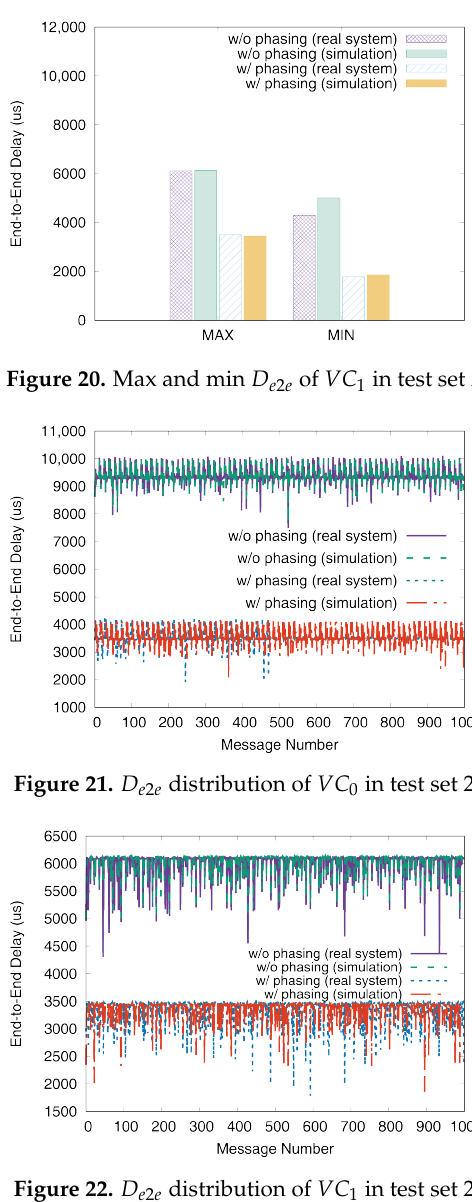
Figure 19. Max and min D e 2 e of VC 0 in test set 2.